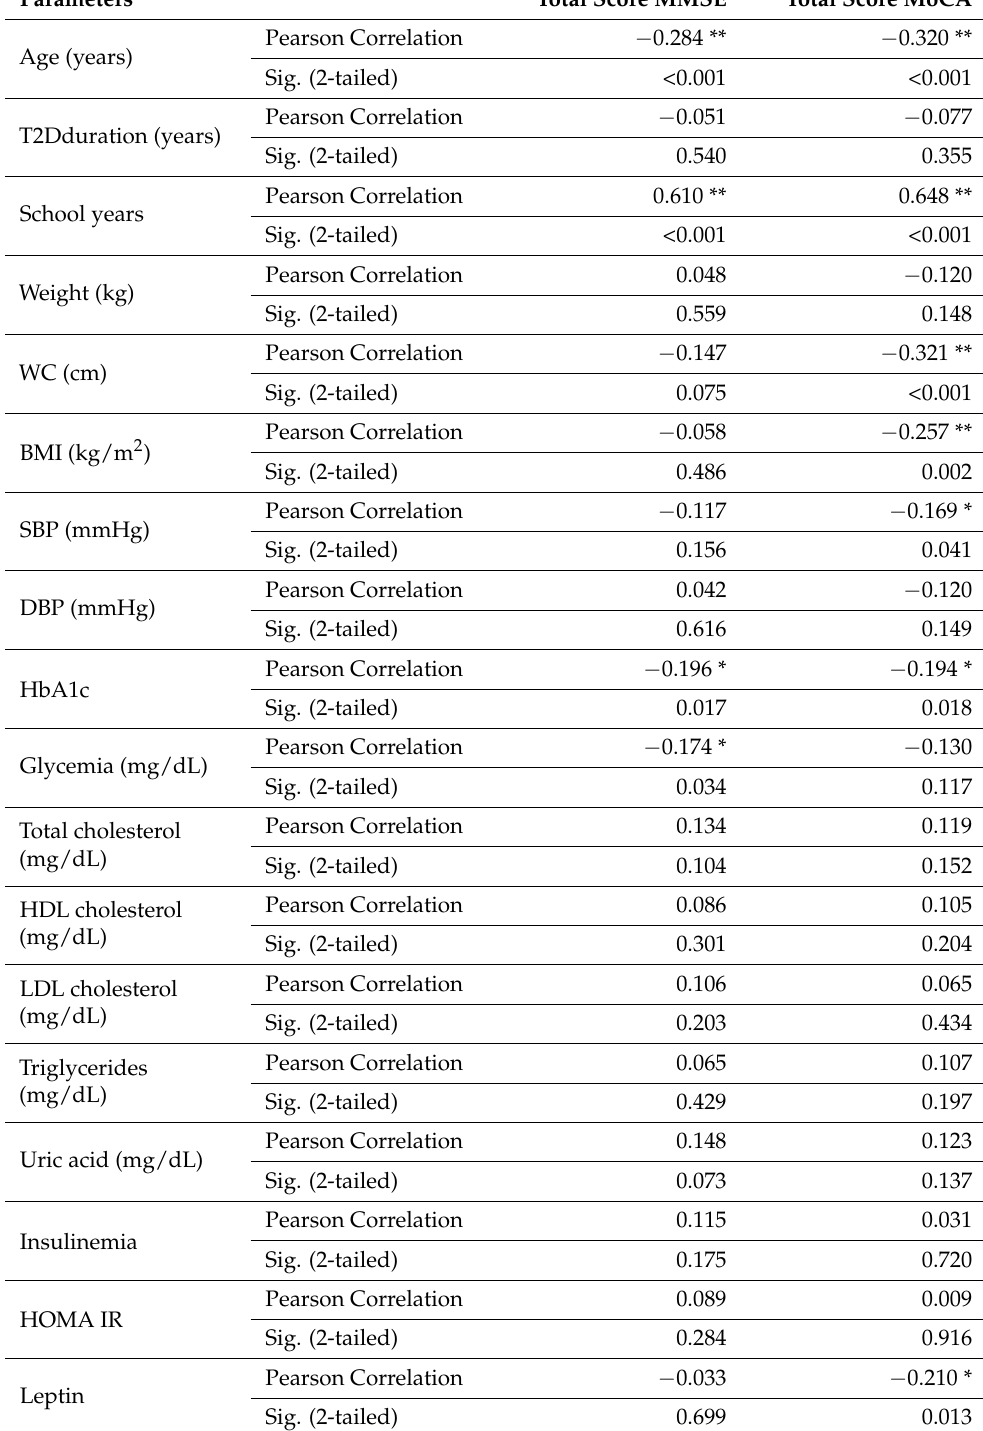
Table 4. Correlations of MMSE and MoCA scores with the studied